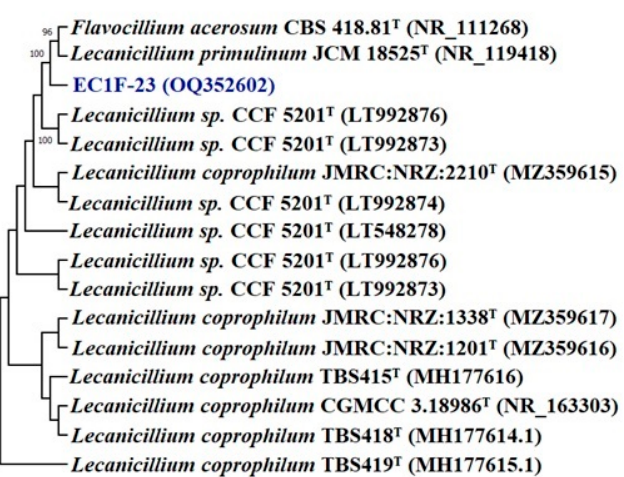
Figure 2. Phylogenetic tree of isolate Lecanicillium sp. EC1F-23 obtained by maximum likelihood method based on the Kimura two-parameter model.